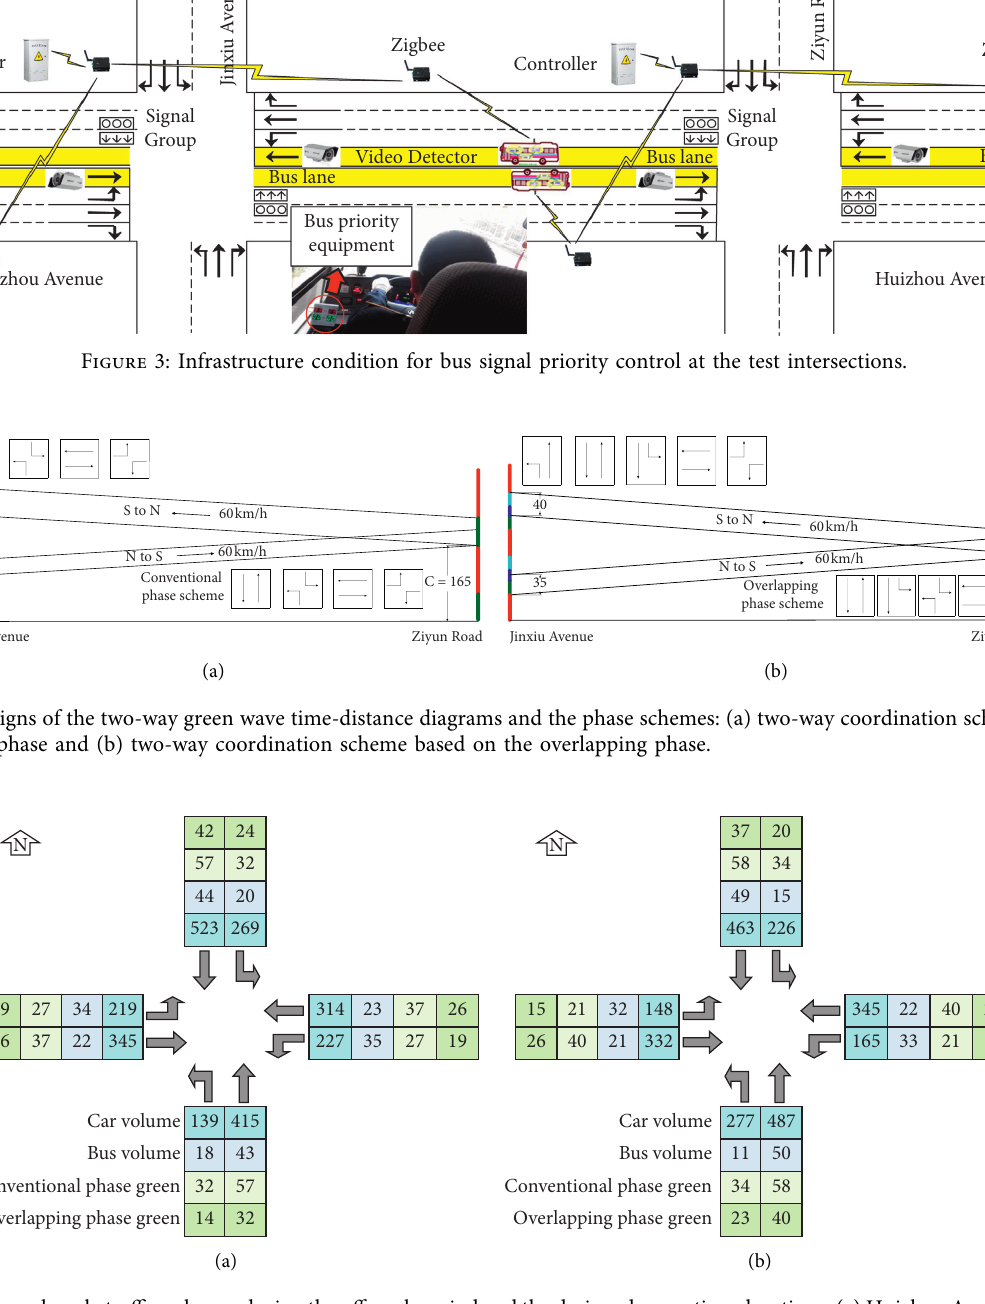
Figure 5: Average hourly traffic volumes during the off-peak period and the designed green time durations. (a) Huizhou Avenue and Ziyun Road intersection. (b) Huizhou Avenue and Jinxiu Avenue intersection.